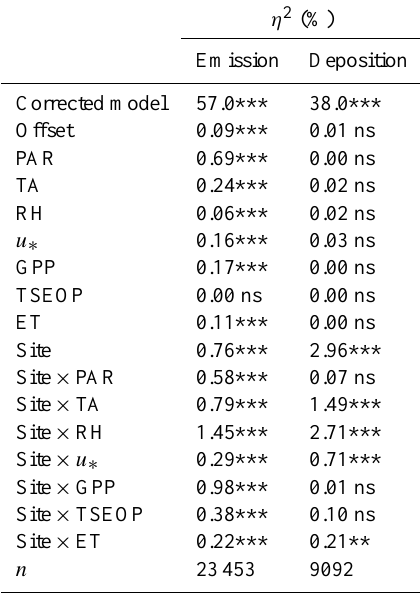
Table 4. Variance explained (partial eta-squared, η 2 ) in methanol emission and deposition based on univariate analysis of variance (UNIANOVA) using all data exclusive of Blodgett Forest and the grassland site data influenced by management activities. See Table 3 for